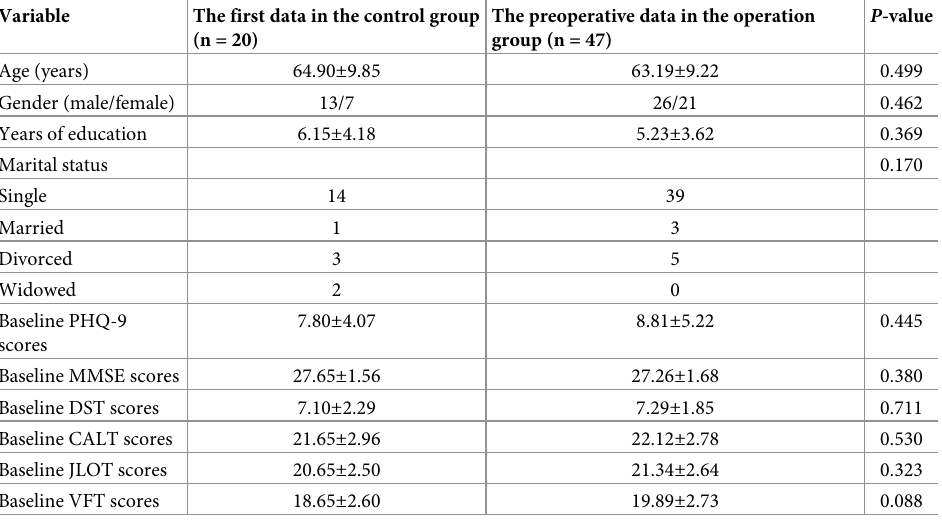
Table 3. The general data and basic cognitive functions of participants from control and operation groups. Variable